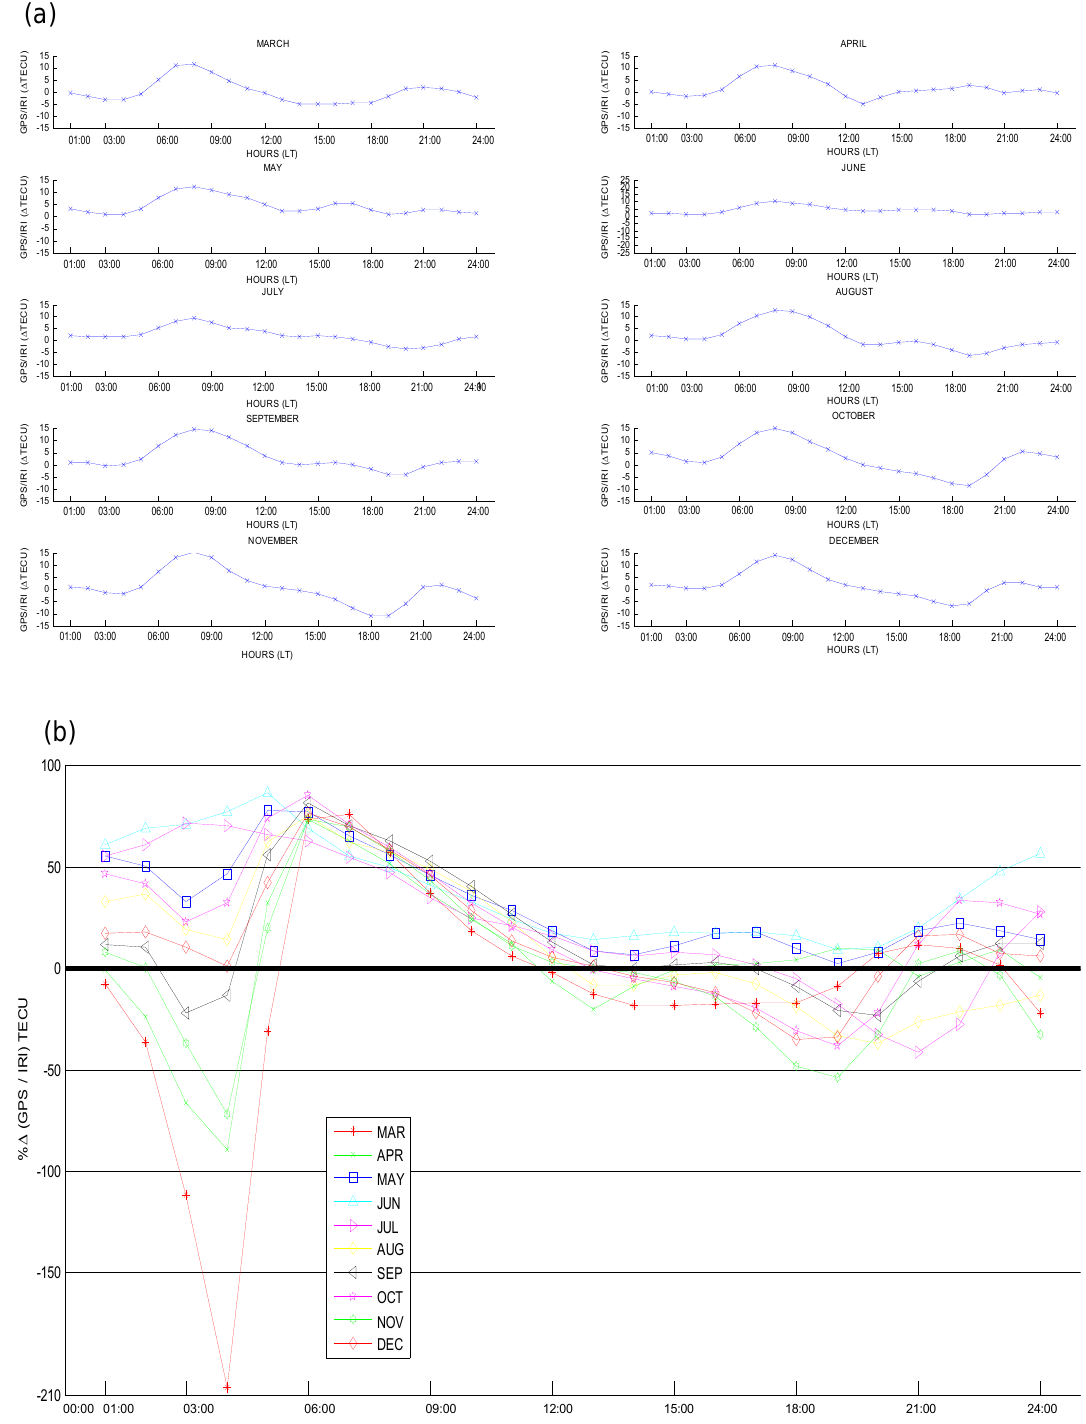
Figure 3. (a) Hourly variations in (cid:49) TEC between the GPS TEC and IRI TEC from March to December during a quiet period. (b) Mass plot of % (cid:49) TEC between the GPS TEC and IRI TEC from March to December during a quiet period. The line colors and symbols are the same as in Fig.